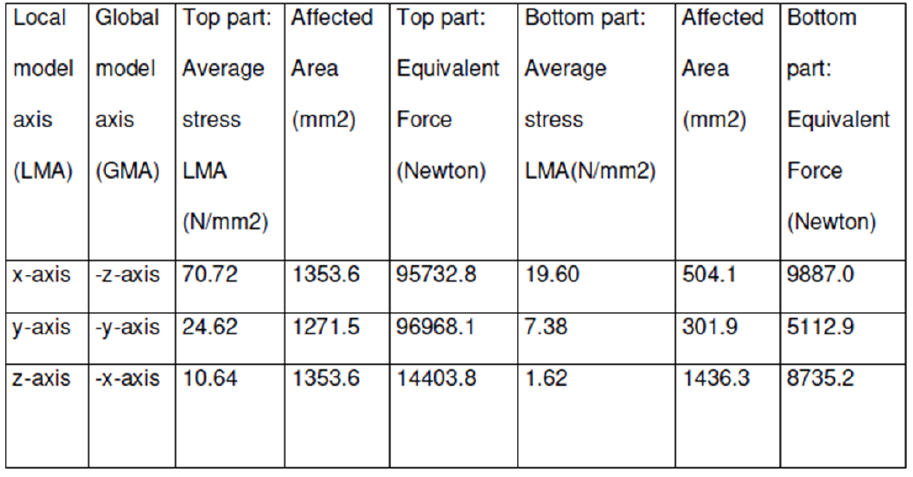
Figure 8. Boundary conditions of wing root joint FEA.